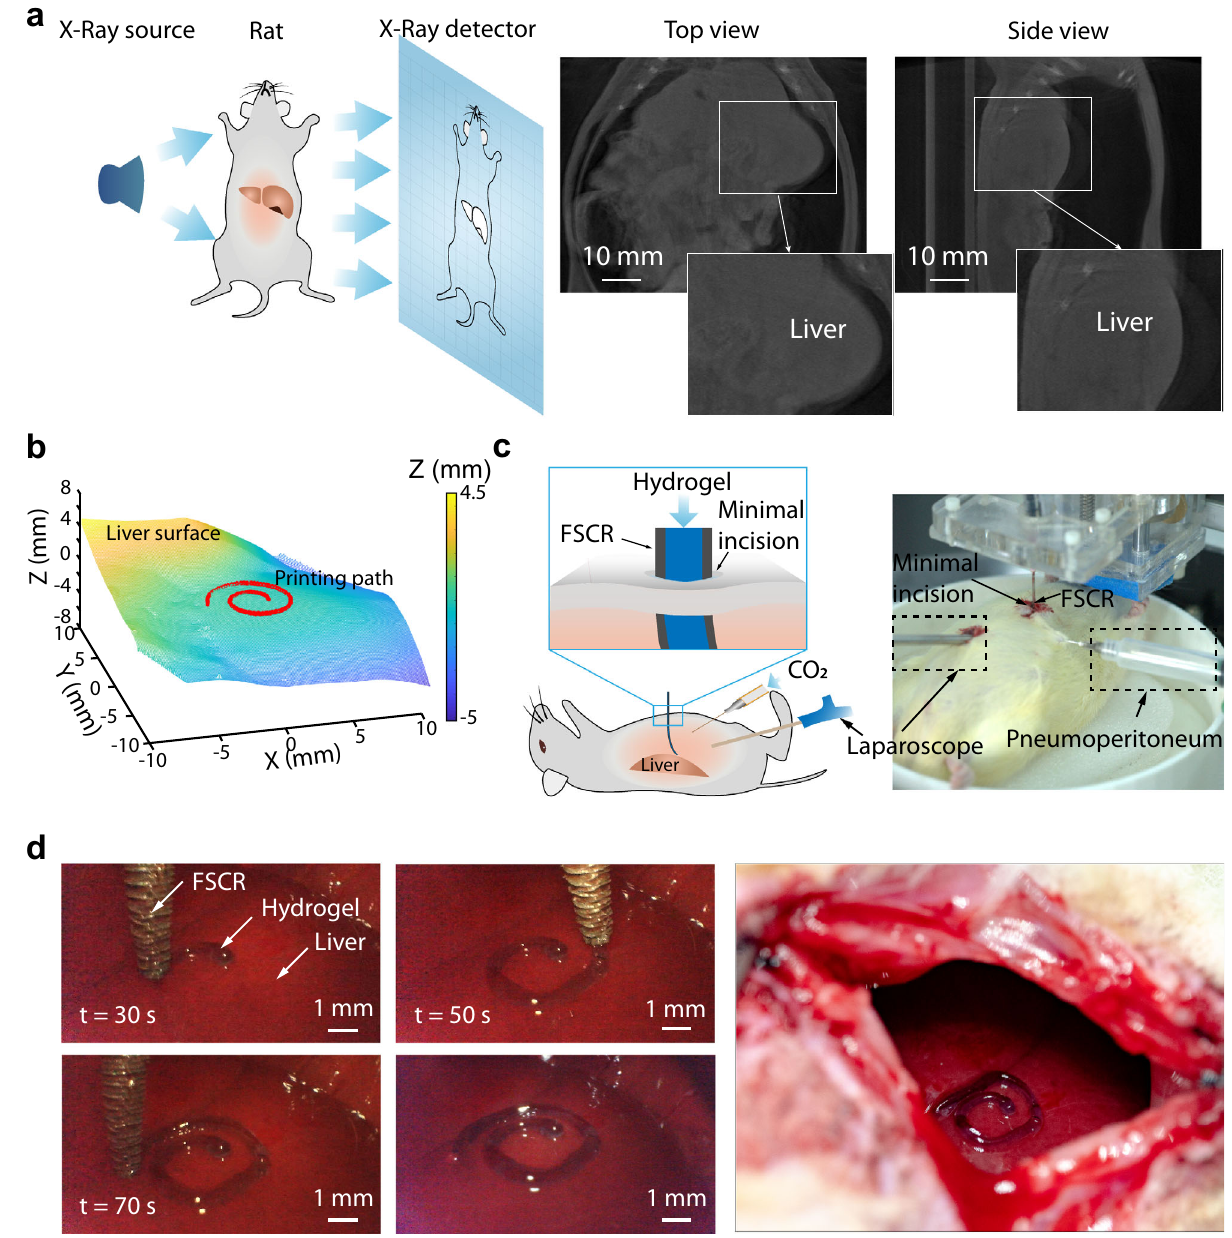
Fig. 6 In vivo minimally invasive printing of conductive hydrogel on rat liver. a Left: schematic of CT imaging of a living rat; Right: CT images of a rat with arti fi cial pneumoperitoneum; Insets show pro fi le of liver. b Reconstruction of the natural surface of rat liver and desired 3D spiral printing path. c Schematic illustration and image of the experimental setup for the in vivo experiment. The color represents the height magnitude. d Left: Photographs of the process of minimally invasive bioprinting with a conductive hydrogel on the liver surface at different times; Right and image of the printed pattern on the surface of the rat